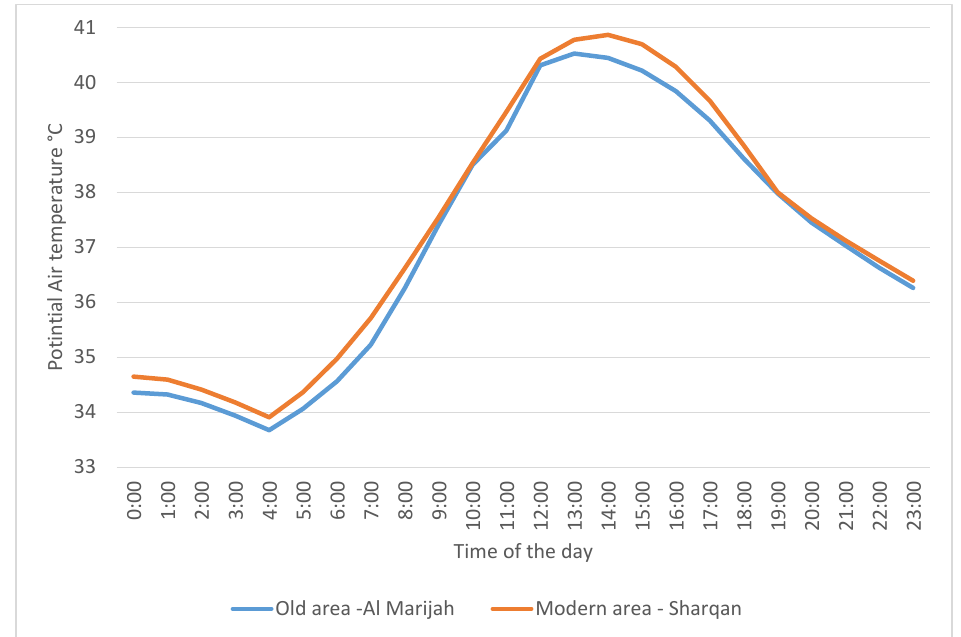
Figure 7. Potential air temperature in both case studies (old and new) on 21st August.